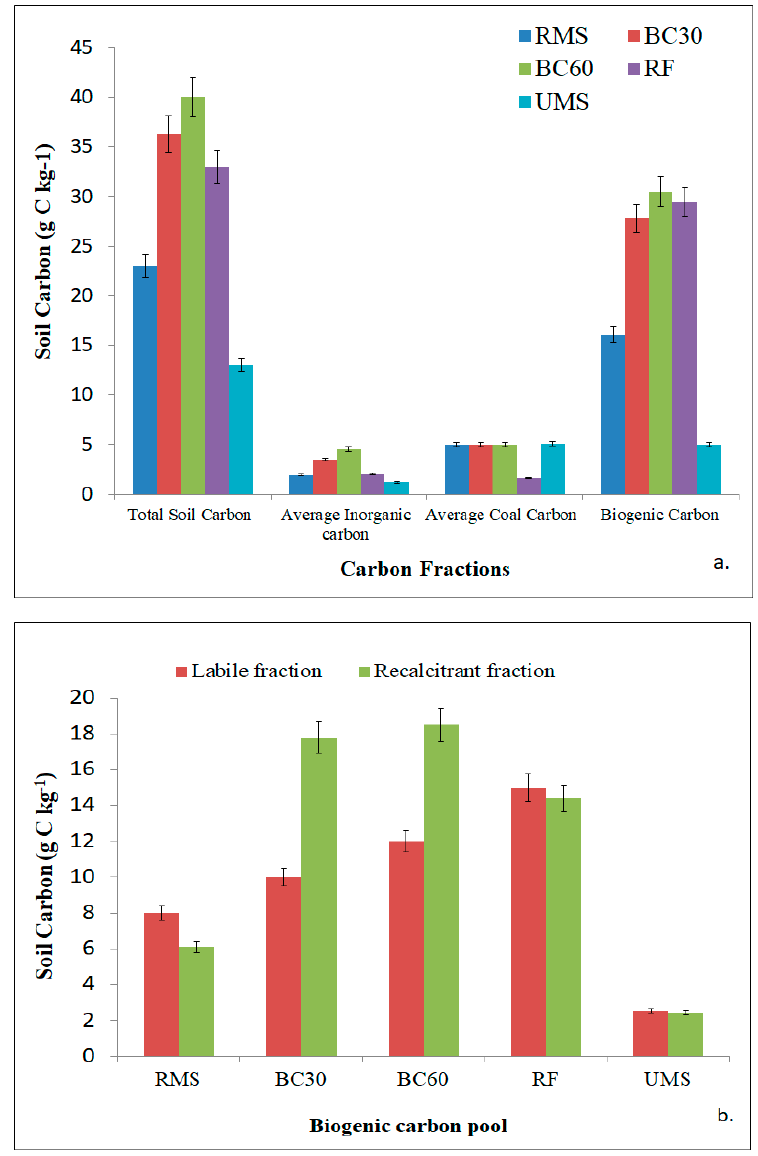
Figure 7. ( a ) Comparison of different carbon fractions in reclaimed mine spoil (RMS), biochar treatment at 30 t ha − 1 (BC 30 ) and 60 t ha − 1 (BC 60 ), reserved forest (RF) and unreclaimed mine spoil (UMS). ( b ) Comparison of labile and recalcitrant carbon fractions in RMS, BC 30 , BC 60 ,RF and UMS.